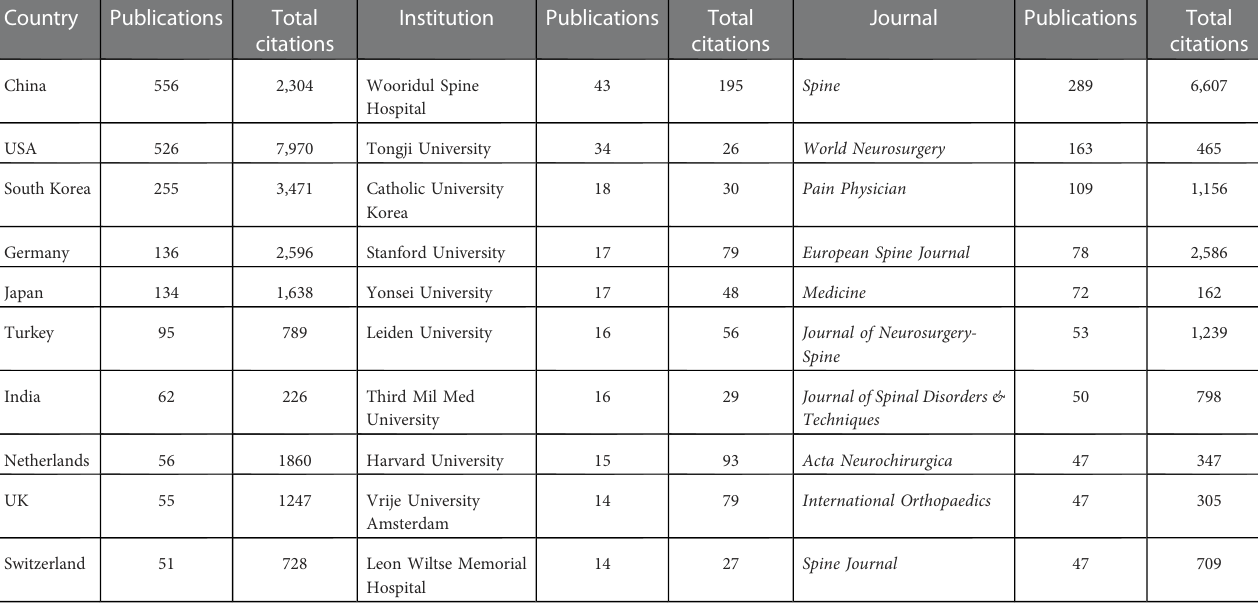
TABLE 1 The top 10 countries/regions, institutions, and journals contributing to publications in discectomy. Country